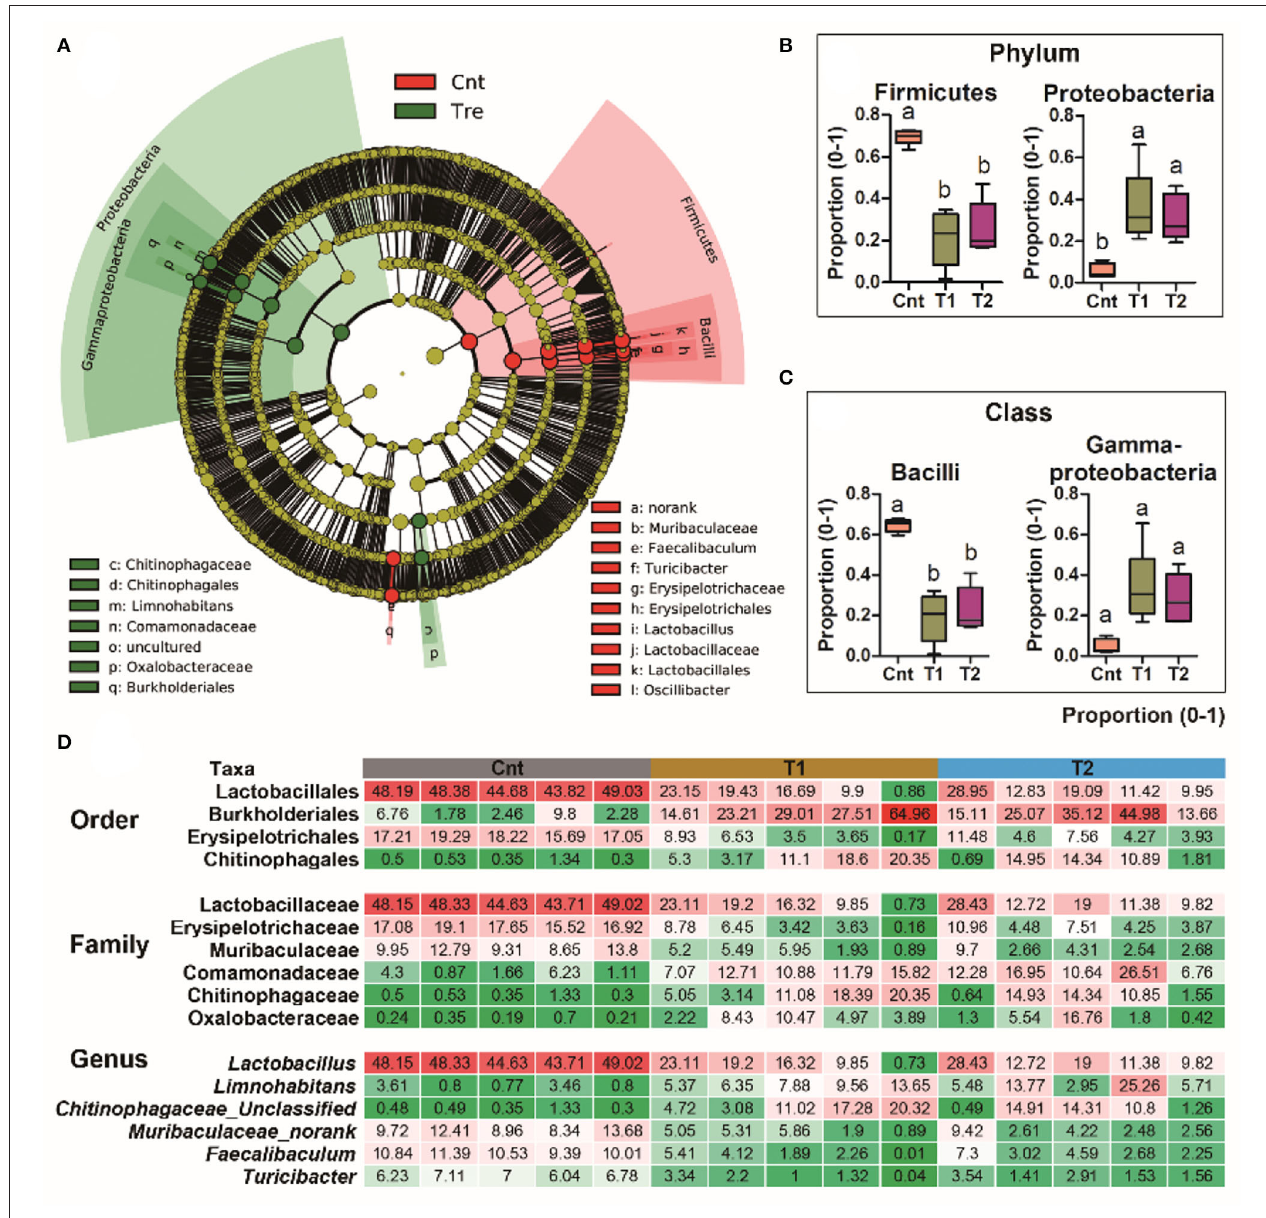
FIGURE 4 | Differential analyses of the oral microbiota between control and treatment groups. (A) A LEfSe analysis on the oral bacteria composition between control and treatment groups. (B,C) The primary variations at phylum and class levels. Data are presented as boxplots ( n = 5). Different superscripts denote significant differences between groups ( p < 0.05, one-way ANOVA and LSD post-hoc tests). (D) Heatmap presents the major variations of microbiota at order, family, and genus levels. The values denote the abundances in